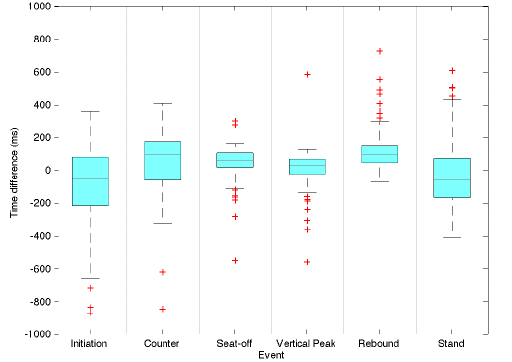
Figure 4: Box plot of time differences for each event. The line represents the median, box represents the 1-3rd quartile, and whiskers represents the extremum points not considered outliers. The red +s represent